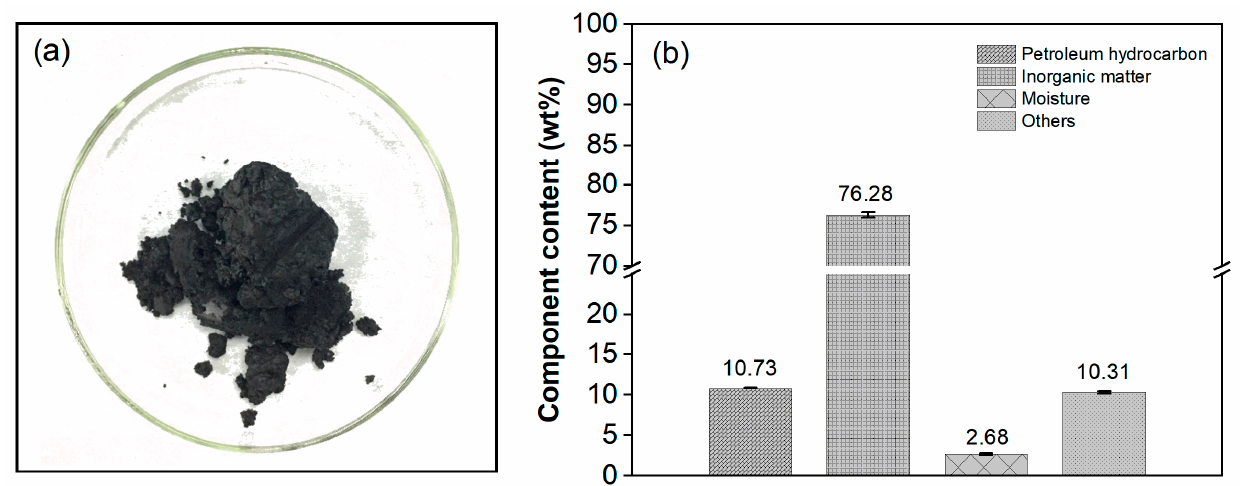
Figure 2. Morphology ( a ) and composition distribution ( b ) of ODBCs produced from a deep shale gas well site in the southern Sichuan Basin, China.